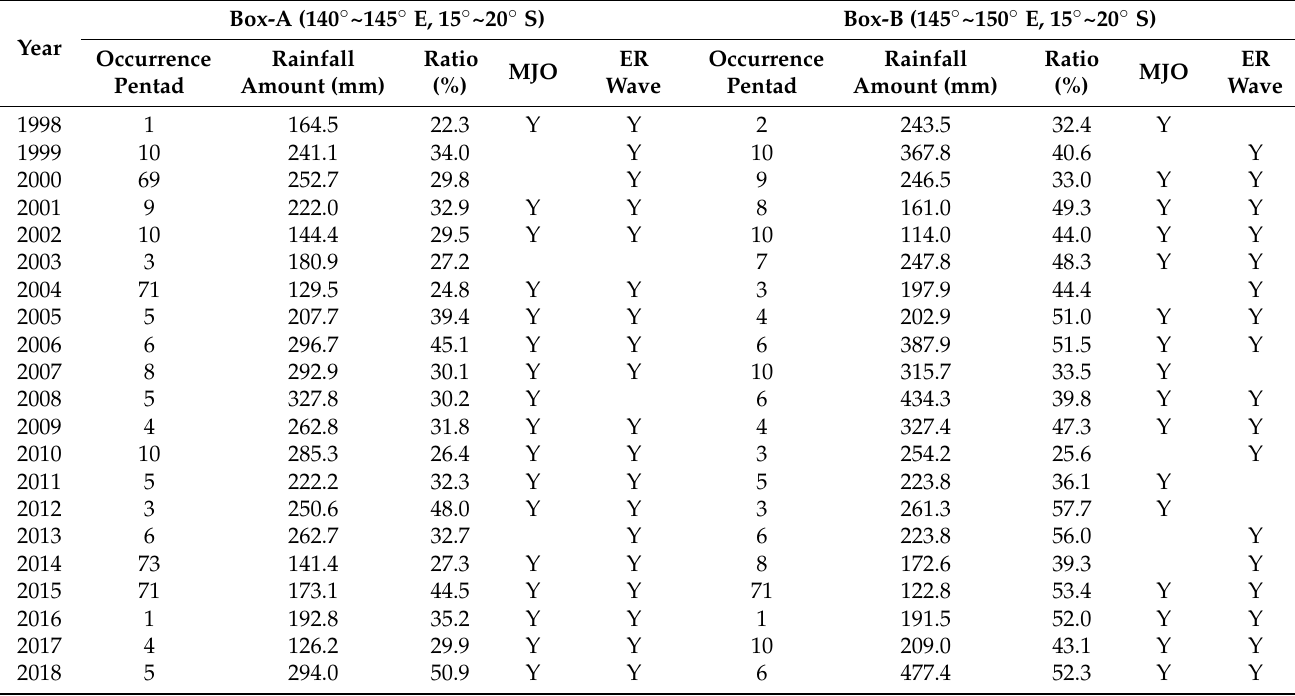
Figure 4. ( a ) The precipitation averaged over 15 ° ~20 ° S (shading, unit: mm day − 1 ). The solid contours mark out the convective phase of MJO determined by the filtered OLR and the dashed contours mark out the convective phase of the ER waves. The location and period of the 2018/19 SPRE are marked out by the dotted box. Identification procedure of the MJO and ER convective phases is described in Section 2.2. ( b ) The real-time multivariate MJO (RMM) index downloaded from the BoM website (http://www.bom.gov.au/climate/mjo/graphics/rmm.74toRealtime.txt) from 27 December 2018 to 14 February 2019. The period of 2018/19 SPRE is in red. Table 3. The occurrence pentad (the first pentad), 15-day accumulative rainfall (unit: mm), and the ratio to DJF totals of each SPRE for two box areas over northern Queensland. Checkmarks (Y) are made when convective phase MJO or ER wave occurred during the